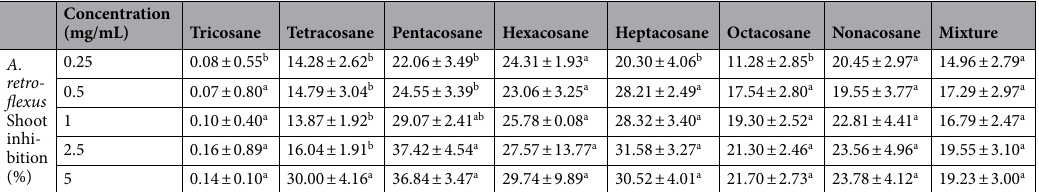
Table 3. Phytotoxic activity of alkanes on shoot growth of A. retroflexus . a ± Standard error ( n = 30). b Different letters represent a significant difference at p < 0.05 level according to Fisher’s LSD